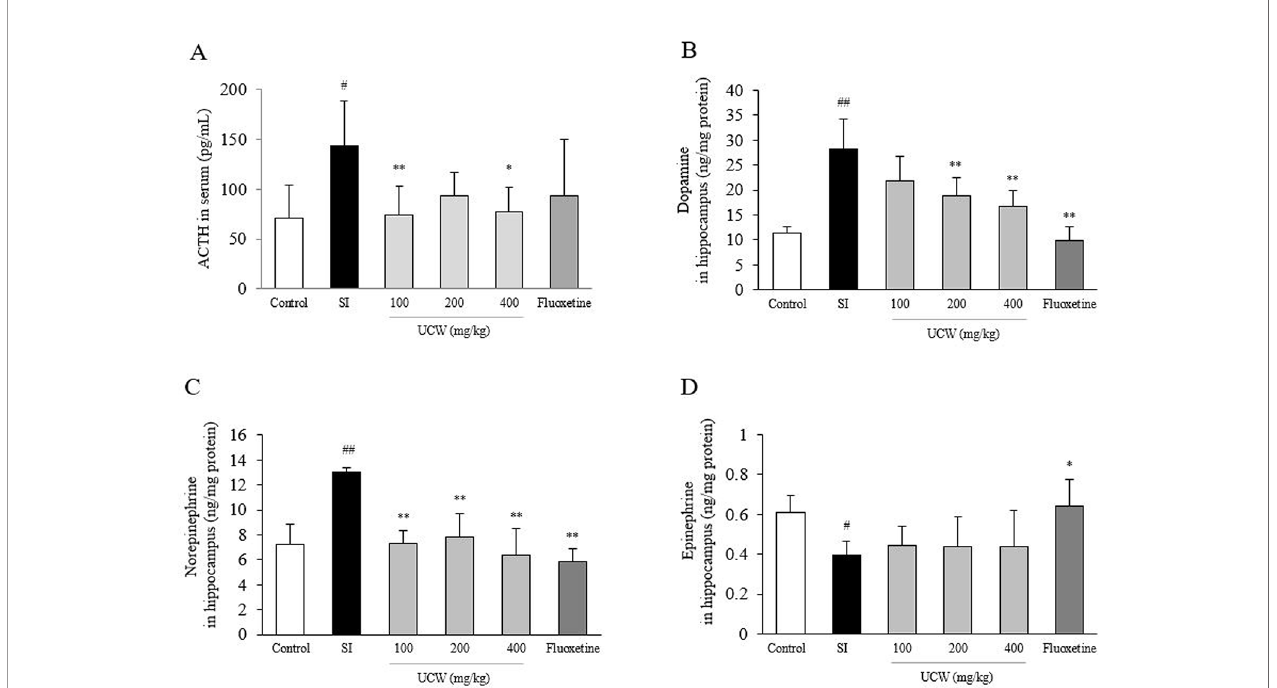
FIGURE 5 | Effects of UCW on the level of serum ACTH and three catecholamines in the hippocampus. Serum level of ACTH (A) was measured, and then levels of dopamine (B) , norepinephrine (C) , and epinephrine (D) in the hippocampus were measured. Data are presented as the mean ± SD (n = 5). # P < 0.05, ## P < 0.01 compared with the control group; *P < 0.05, **P < 0.01 compared with the social isolation (SI) group.